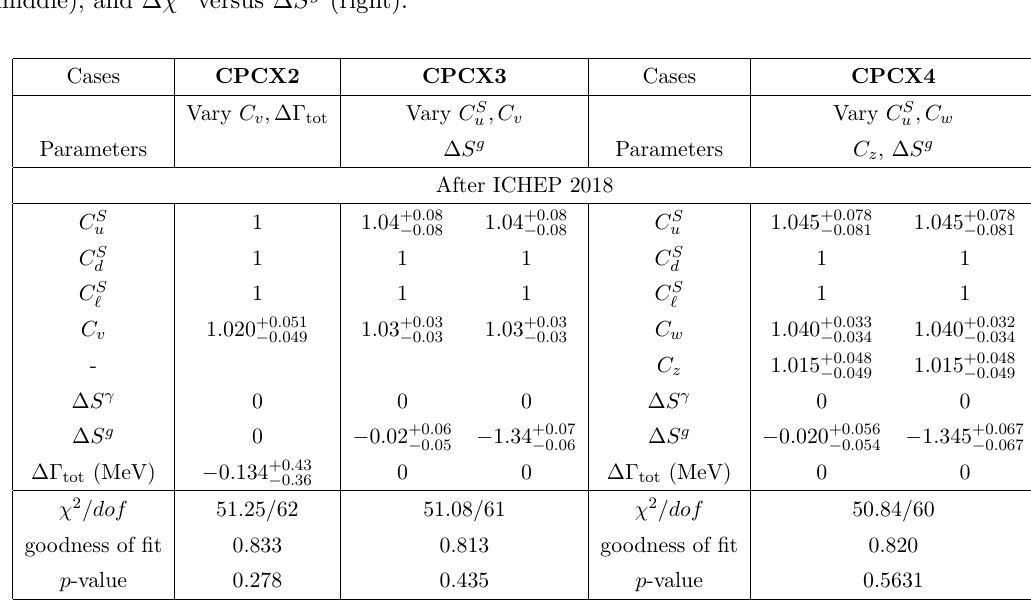
Figure 8 . CPCN4 : (Upper) The con(cid:12)dence-level regions of the (cid:12)t by varying (cid:1) S g , (cid:1) S (cid:13) , C S and C v . The color code is the same as in (cid:12)gure 2. (Lower) (cid:1) (cid:31) 2 versus C S (middle), and (cid:1) (cid:31) 2 versus (cid:1) S g (right).